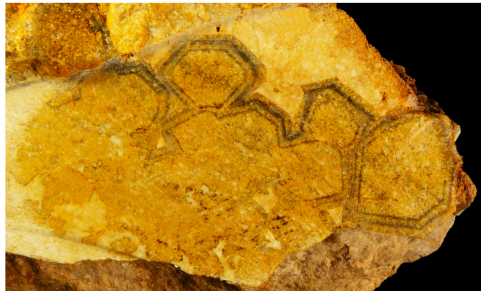
Figure 5. Sawn surface showing tan dolomite encasing brown quartz with oriented layers of